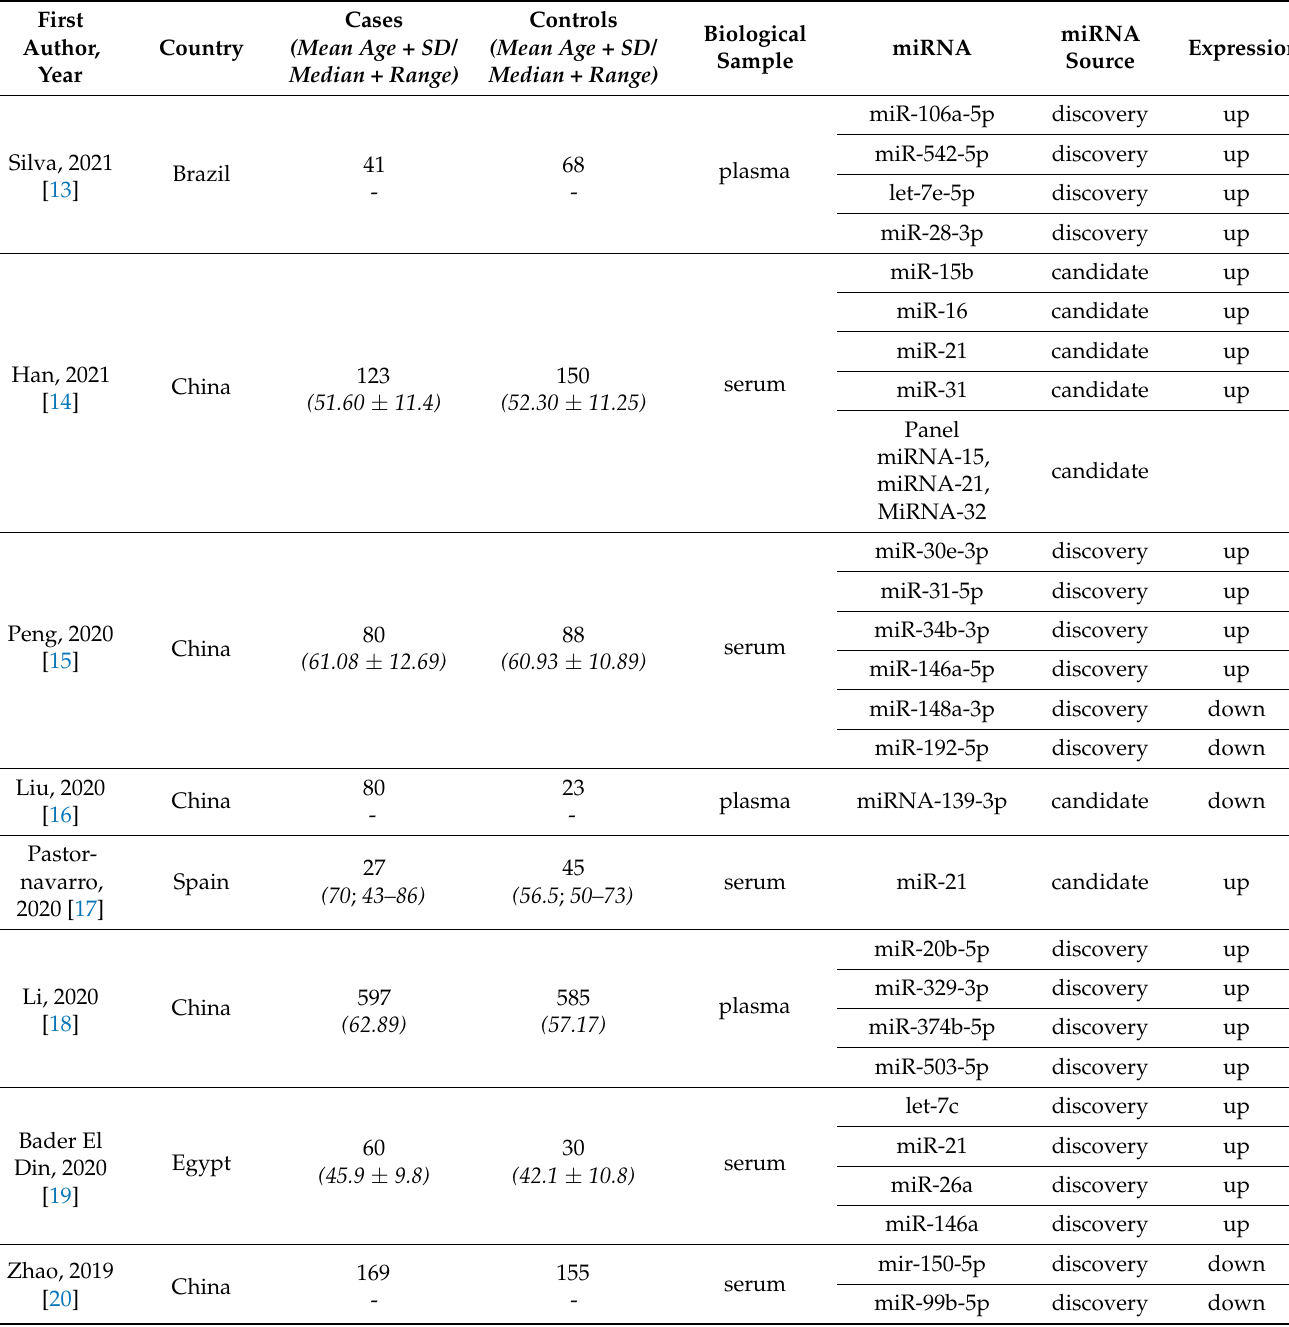
Table 1. Study characteristics of the forty-four studies included in the systematic